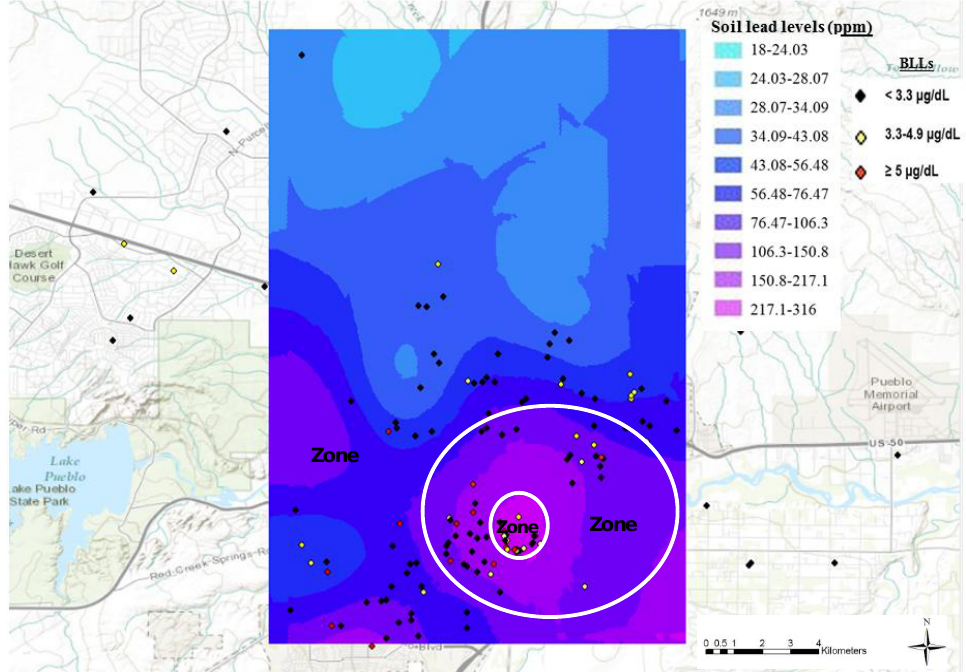
Figure 2. Blood lead levels and geographical coordinates of children superimposed on the spatial soil lead distribution prediction map. All the data points in the figure represent the actual geo-physical locations of the 240 children who were tested for blood lead level during the current study in the summer of 2013; these data are not based on previous studies or prediction maps. Each dot represents the site where participating children lived. The black, yellow and red colors represent <3.3 µ g/dL, 3.3–4.9 µ g/dL and ≥ 5 µ g/dL BLLs, respectively. The main smelter, the Colorado Smelter, was located in Zone 1 and the other smelters were located in Zone